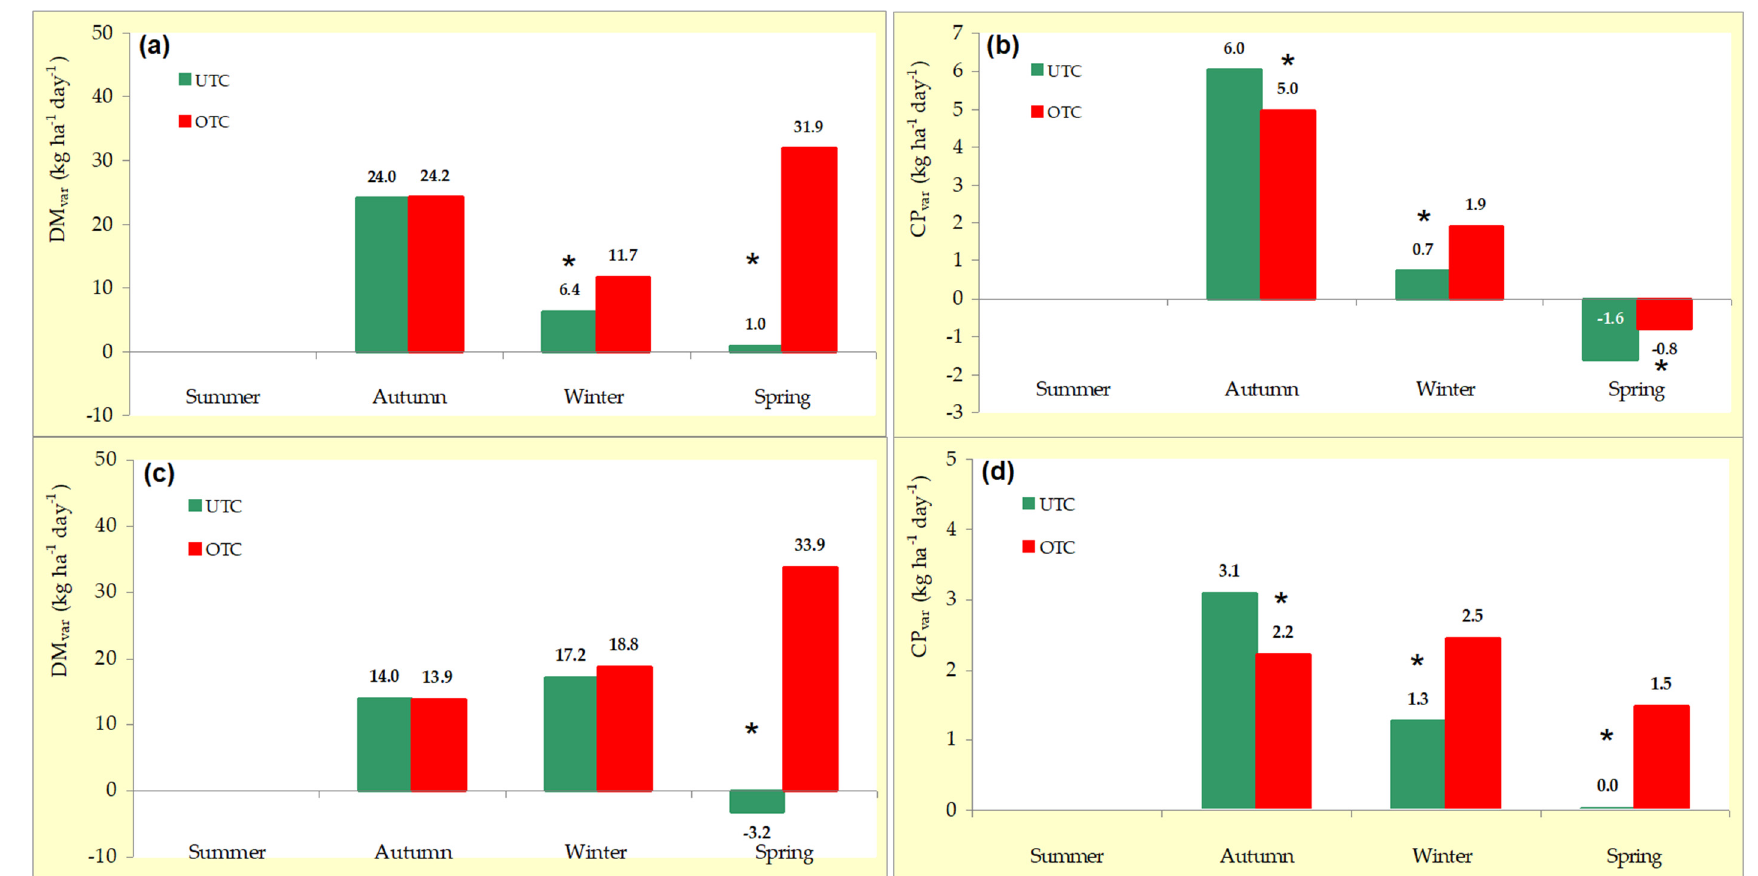
Figure 6. Pasture daily growth rate (kg·ha − 1·day − 1) under tree canopy (UTC) and outside tree canopy (OTC), in the vegetative cycles of 2018/2019 (( a , b ), respectively dry matter, DMvar and crude protein, CPvar) and 2019/2020 (( c , d ), respectively dry matter, DMvar and crude protein, CPvar). * Significant at the 0.05 level.